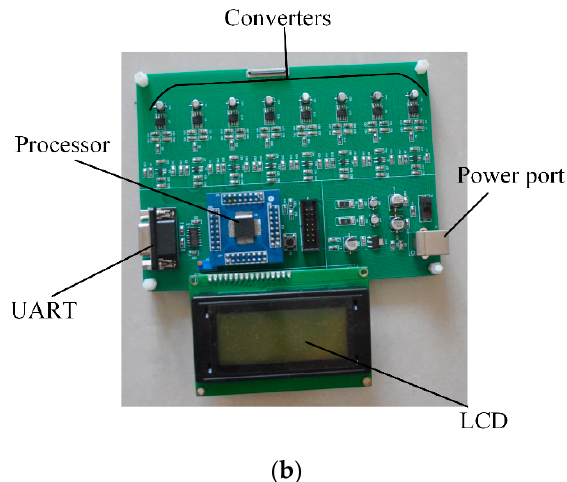
Figure 8. ( a ) Block diagram of the signal processing system; ( b ) the implemented signal processing system.